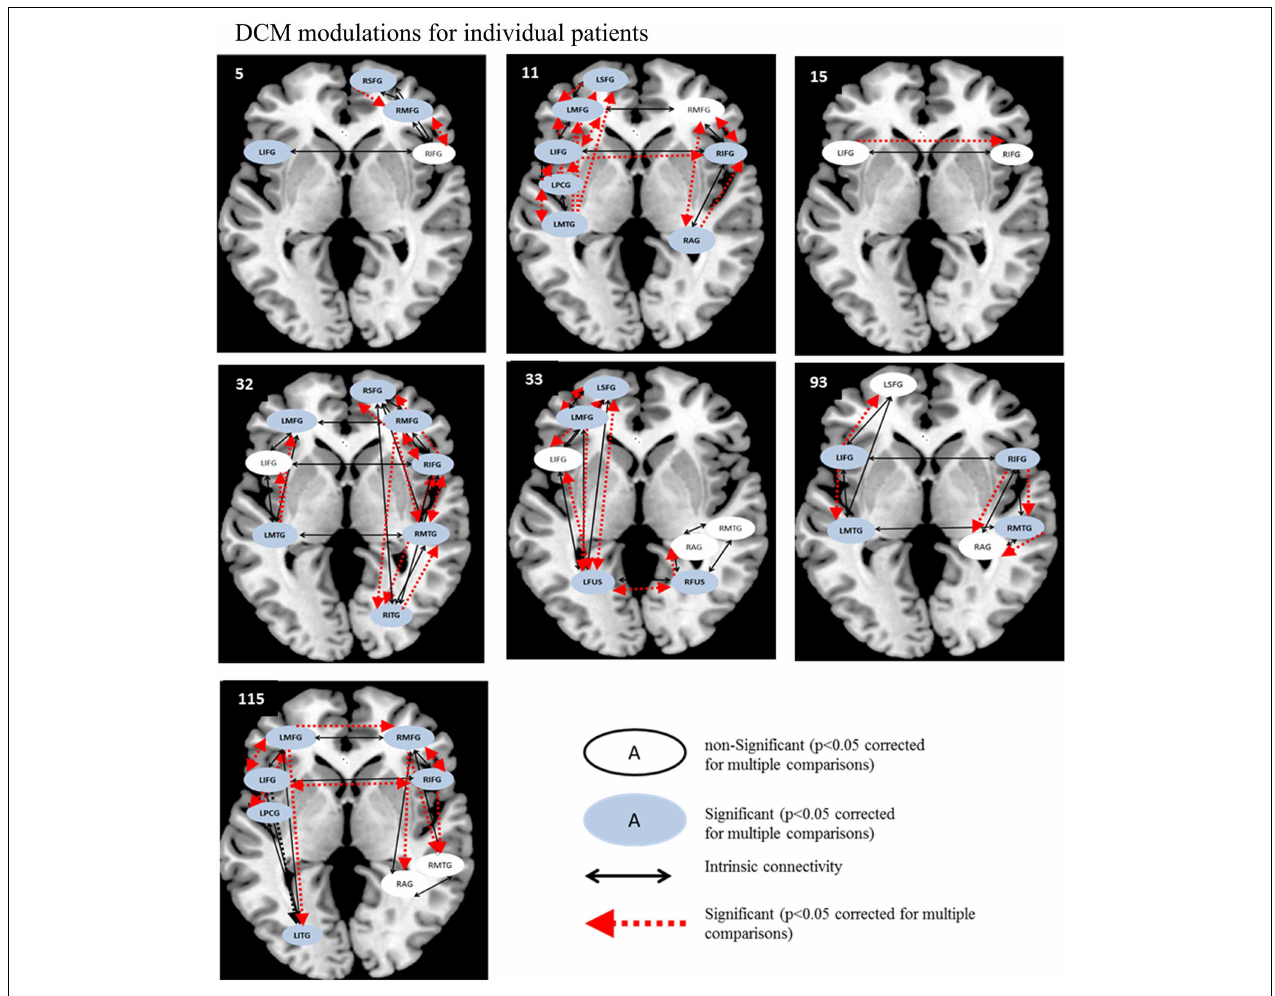
FIGURE 8 | Series of images showing individual patients’ connectivity networks as a function of rehabilitation for the trained category on the semantic feature verification task. Regions with significant modulations